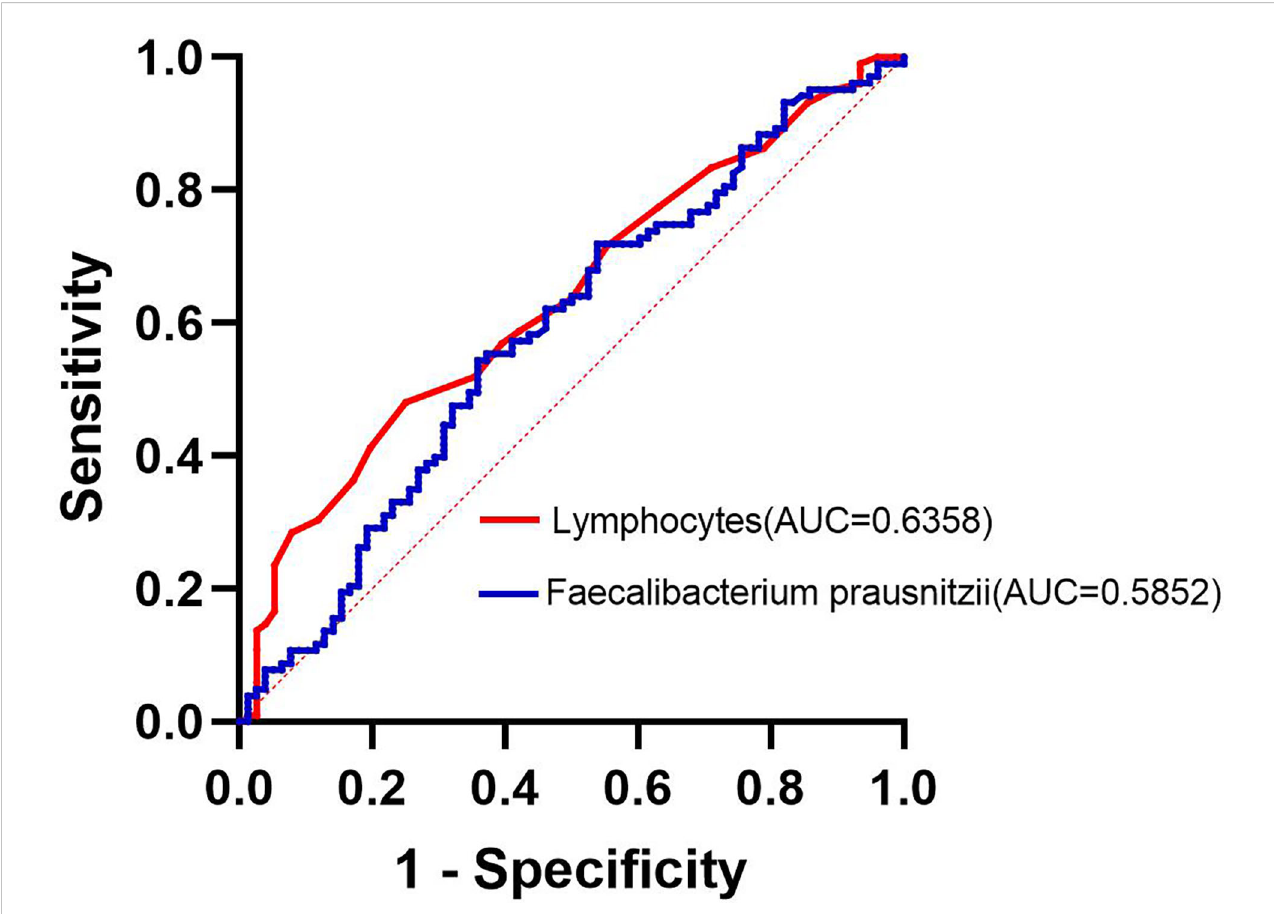
FIGURE 7 Lymphocytes and F. prausnitzii ROC curve analysis for predicting the development of NAFLD in obese patients.